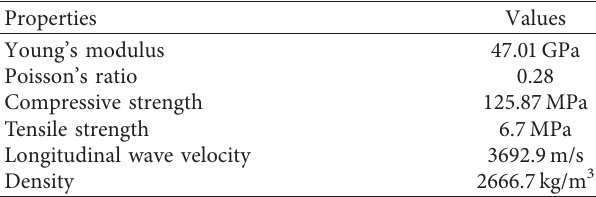
Table 1: Mechanical parameters of tested granite